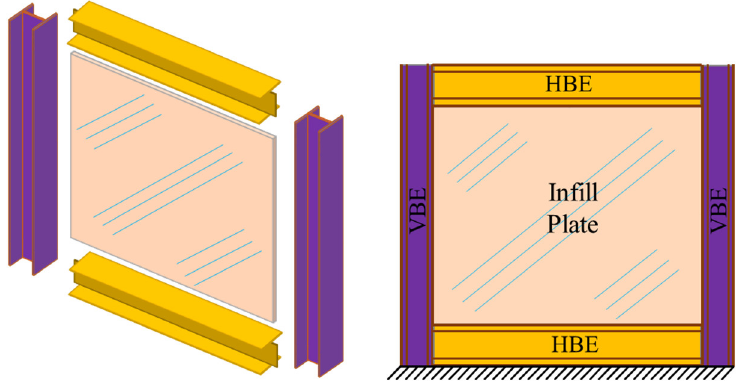
Figure 1. Typical steel plate shear wall.